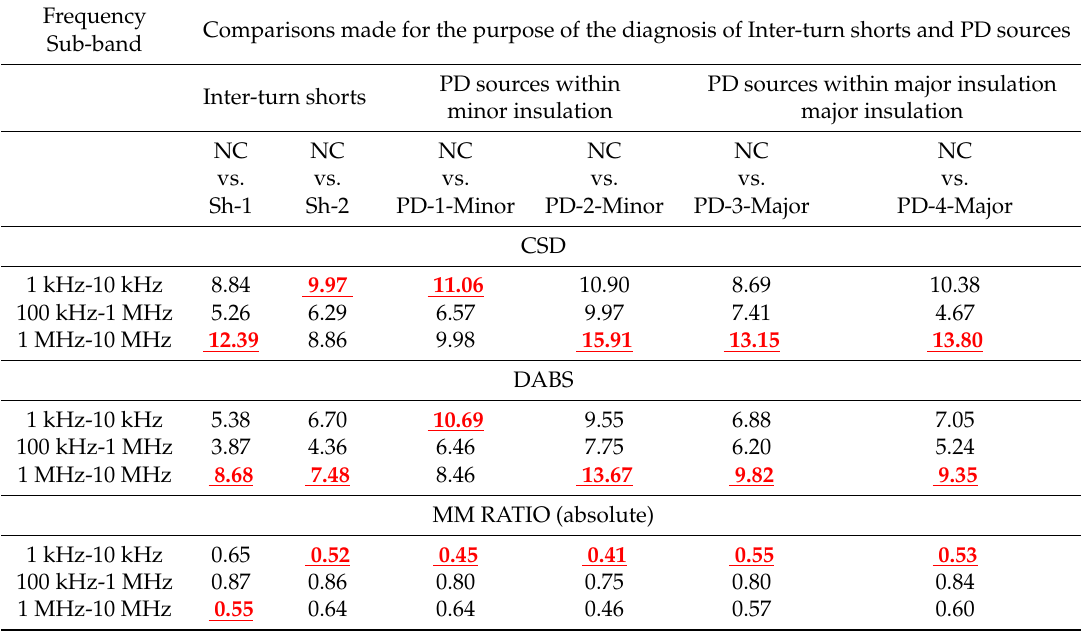
Table 3. Comparison between the normal and various faulty cases on statistical parameter basis Statistical Parameter Values Calculated during Different